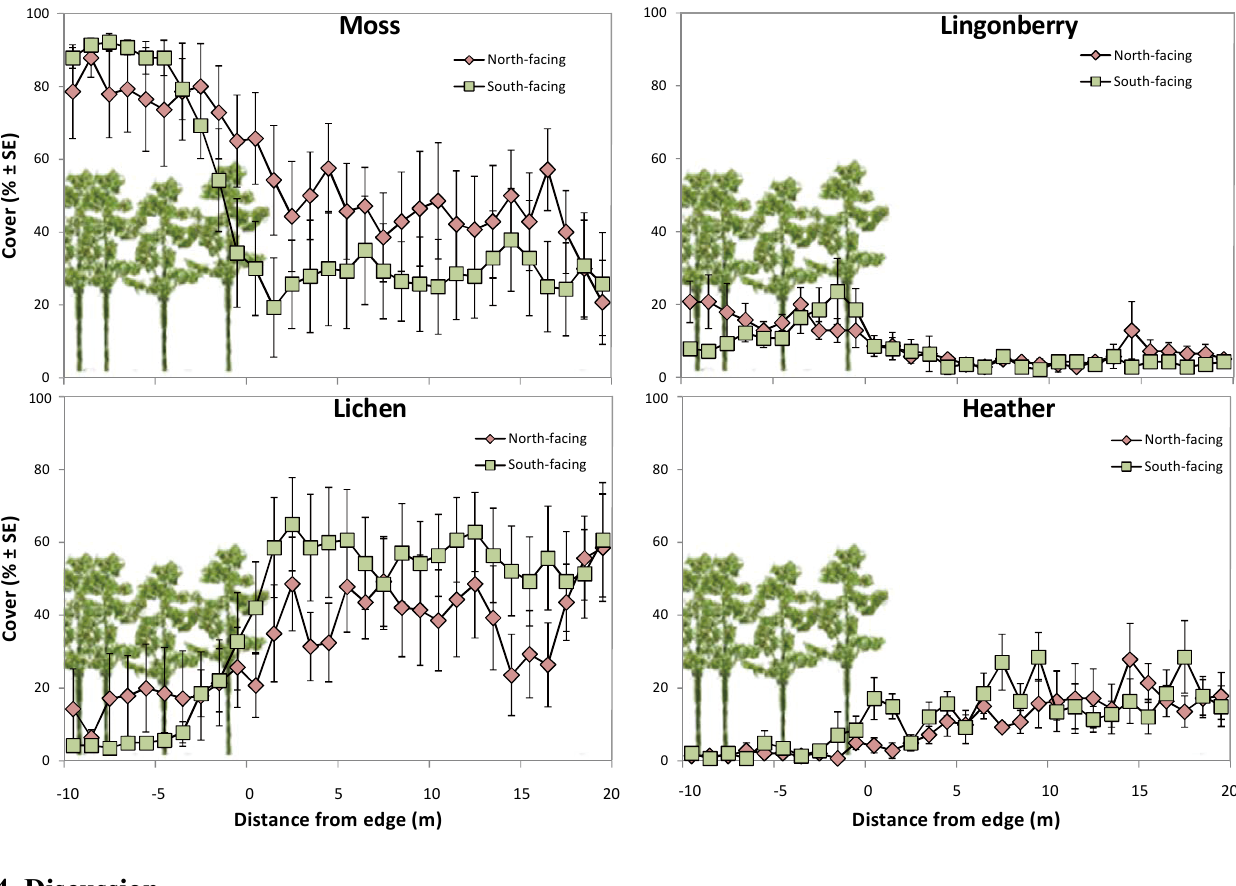
Figure 4. Cover (%) of dominant understory species along 30-m transects going from the closed forest into forest gaps. On the x -axis, 0 m denotes the forest edge. The forest edges faced either north or